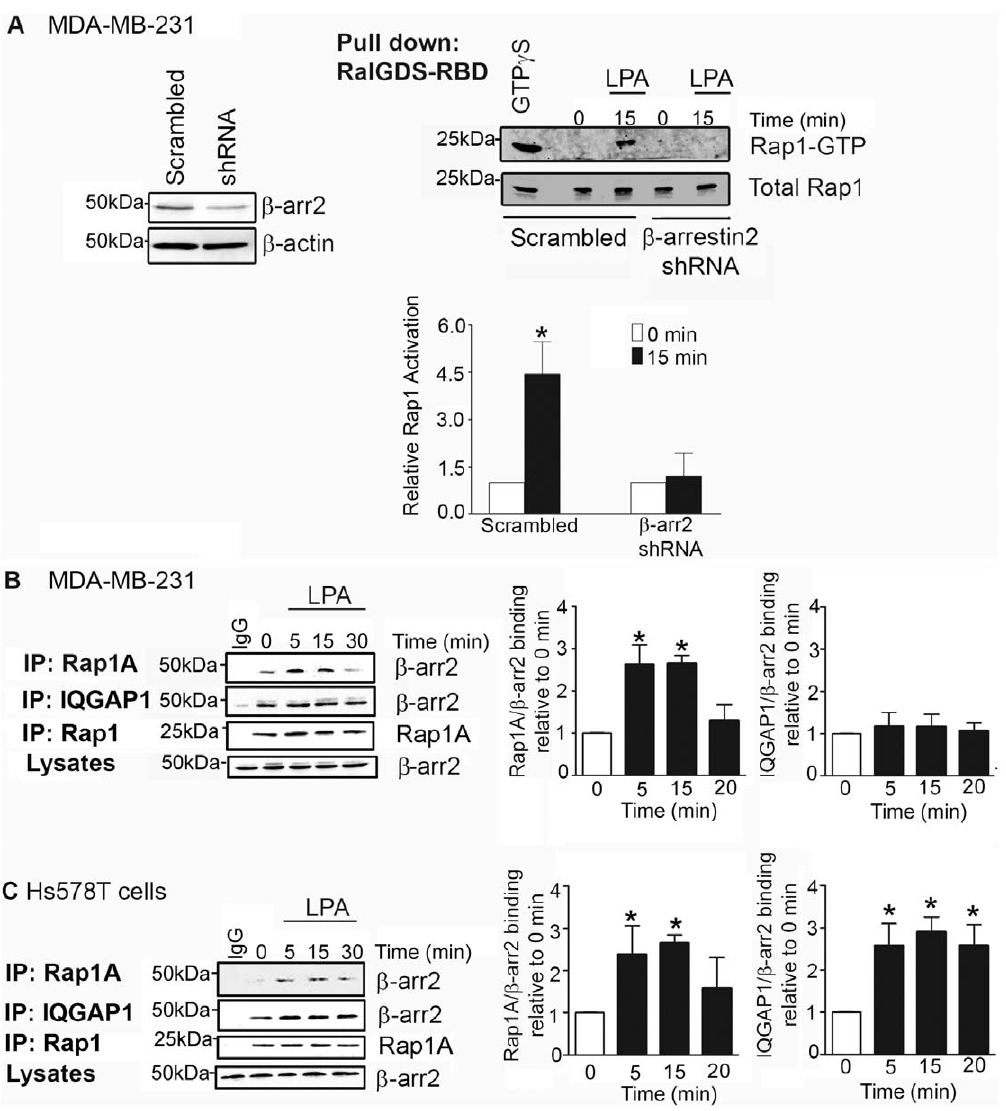
Figure 5. b -arrestin2 regulates Rap1 activity and associates with Rap1A and IQGAP1 in breast cancer cells. (A) Depletion of b -arrestin2 in breast cancer cells blocks LPA-induced Rap1 activation. MDA-MB-231 cells stably expressing either scrambled shRNA or b -arrestin2-targeting shRNA were serum starved for 4 hours and stimulated with 10 m M LPA. Cells were lysed and activated Rap1 was pulled down. Knockdown of b - arrestin2 in MDA-MB-231 cells stably expressing shRNA against b -arrestin2 was verified by Western blot analysis. Representative blots from four independent experiments are shown. (B) The association of endogenous proteins, b -arrestin2, Rap1A and IQGAP1, in breast cancer cells. MDA-MB-231 cells were serum-starved for 4 hours and stimulated with LPA in serum-free media (10 m M). Isolated lysates were subjected to co- immunoprecipitation assays using a rabbit anti-Rap1A antibody or rabbit anti-IQGAP1 antibody and immunoblotted using a monoclonal anti- b - arrestin2 antibody. A representative blot from four independent experiments is shown. Graph illustrates densitometric analysis of blots; data are expressed relative to unstimulated cells. Error bar, SEM *, p , 0.05. (C) Endogenous proteins, b -arrestin2, Rap1A and IQGAP1 association in Hs578T cells as described in (B). A representative blot from three independent experiments is